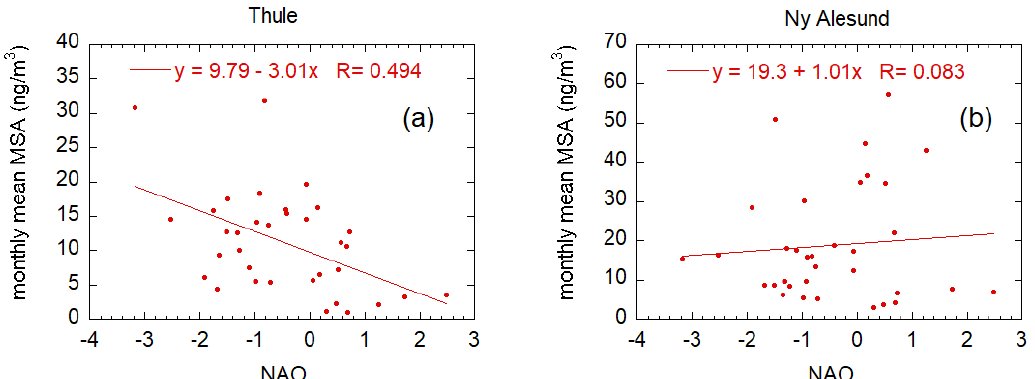
Figure 5. Correlations between monthly mean values of MSA and the North Atlantic Oscillation (NAO) index at Thule ( a ) and at Ny Ålesund ( b ).